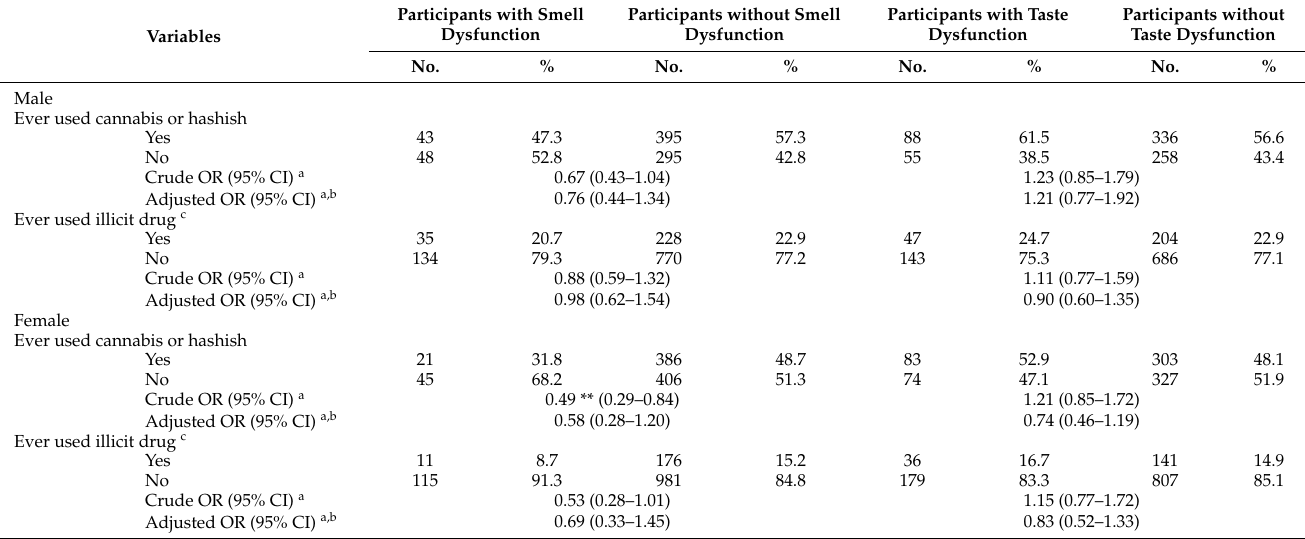
Table 3. Association between cannabis/illicit drug use and smell/taste dysfunction among study participants according to